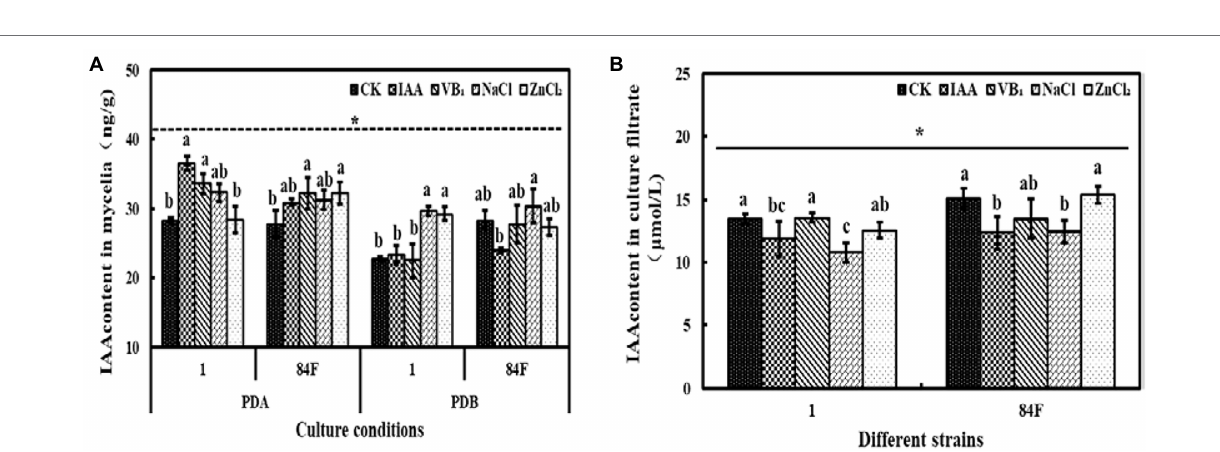
and ZnCl 2 treatments were significantly higher ( p < 0.05) than those with VB 1 treatment ( Figure 6 ).